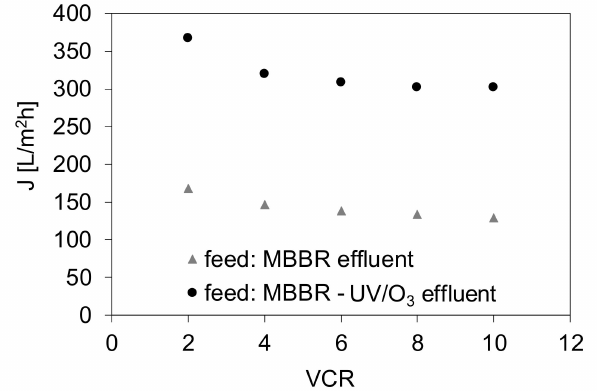
Figure 5. Influence of UV / O 3 treatment on MF permeate flux for various VCR values (TMP = 1 bar in case of MBBR e ffl uent and 2 bar in case of MBBR-UV / O 3 e ffl uent).